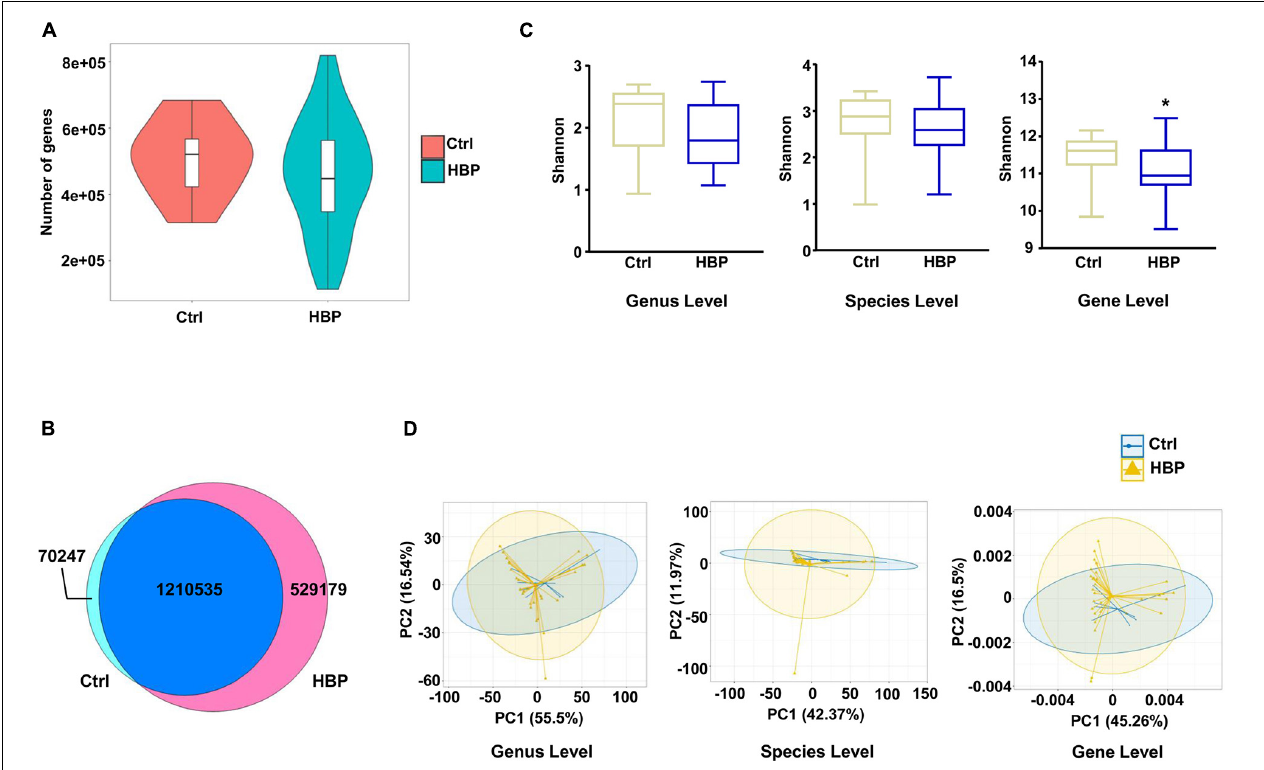
FIGURE 1 | Microbial diversity shows slight difference between healthy control and primary hypertension patients with antihypertension medications. (A) Gene count comparison between the two groups. (B) Venn comparison of the shared gene numbers and unique gene numbers between the two groups. (C) α -Diversity analysis (Shannon index) based on genus, species, and ortholog profile in the two groups. (D) Principal component analysis (PCA) of β -diversity analysis based on genus, species, and orthologs profile between the two groups. Ctrl, healthy control group, n = 8. HBP, primary hypertension patient group who took antihypertension medications before testing metagenomics, n = 30. Gene level, i.e., ortholog level. * p < 0.05 by one-tailed Mann–Whitney U -test.